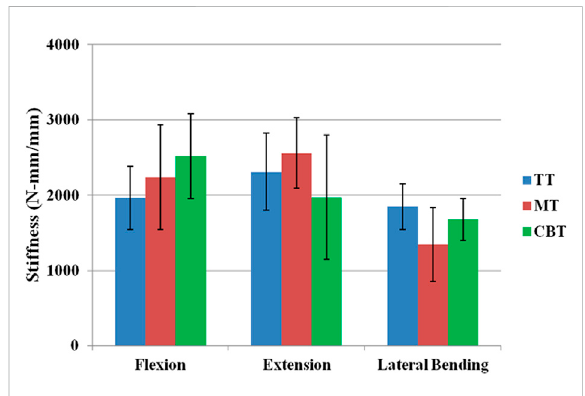
Mean fl exion,extensionandlateralbendingstiffnessesofFSU constructs treated with TT, MT and CBT trajectories. Signi fi cant differences were not observed among the groups in the fl exion, extension and lateral bending motions ( p > 0.05).